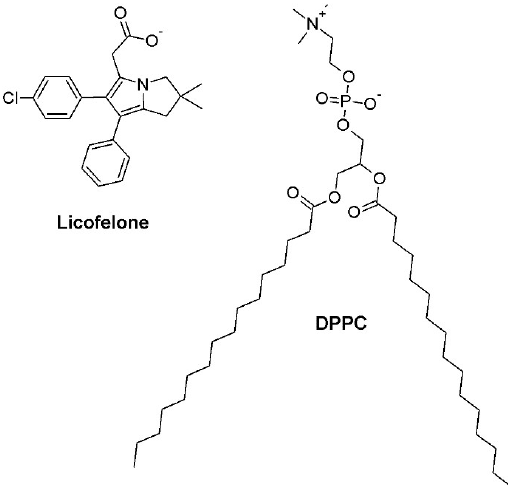
Figure 1. Structural formula of licofelone and 1,2-dipalmitoyl- sn -glycero-3-phosphocholine (DPPC). Lipid monolayers made of 1,2-dipalmitoyl- sn -glycero-3-phosphocholine (DPPC) at physiological pH (7.4) were chosen as membrane model system. Lipid monolayers are simple and easy-to-make membrane model systems that mimic the lateral interactions occurring in one leaflet of